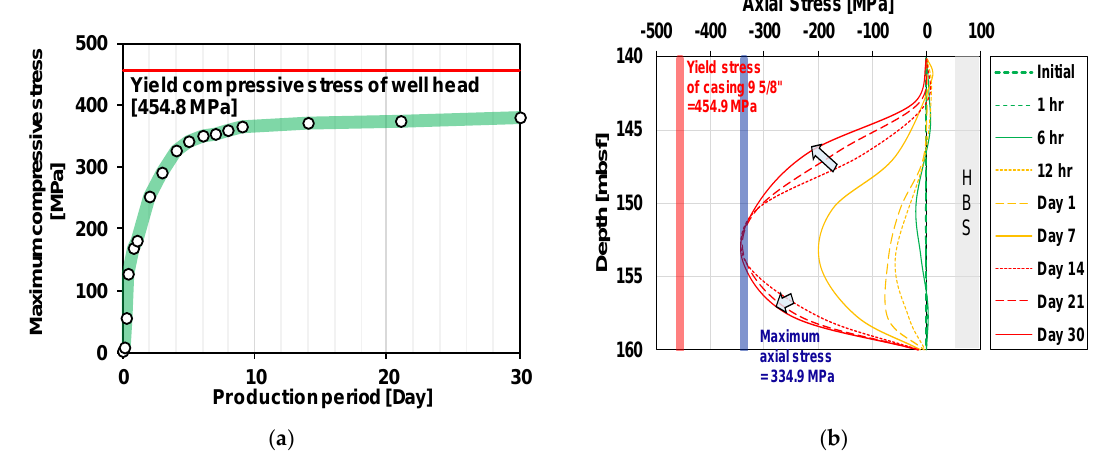
Figure 13. Results of stability analysis considering the coupling stiffness models: ( a ) Development of the maximum axial stresses with production period; ( b ) distribution of axial stress with depth.